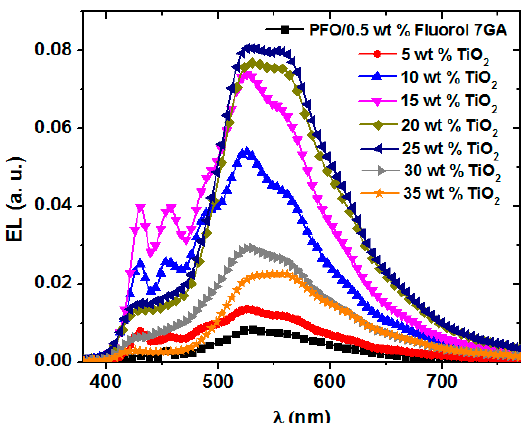
Figure 4. EL spectra of PFO/Fluorol 7GA/TiO 2 devices at applied voltages corresponding to maximum luminance.